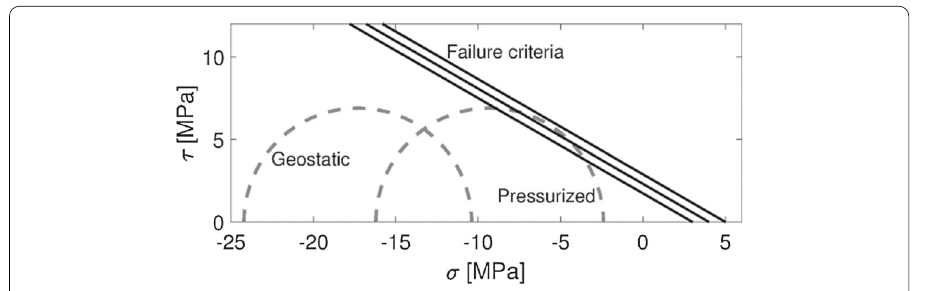
Fig. 6 Sensitivity analysis on tensile strength. Failure surfaces in the Mohr plane for the three values of tensile strength T c = 3 , 4, and 5 MPa. Figure shows two Mohr’s circles corresponding to the geostatic state and to the state characterized by a fluid pressure able to cause the failure of the material